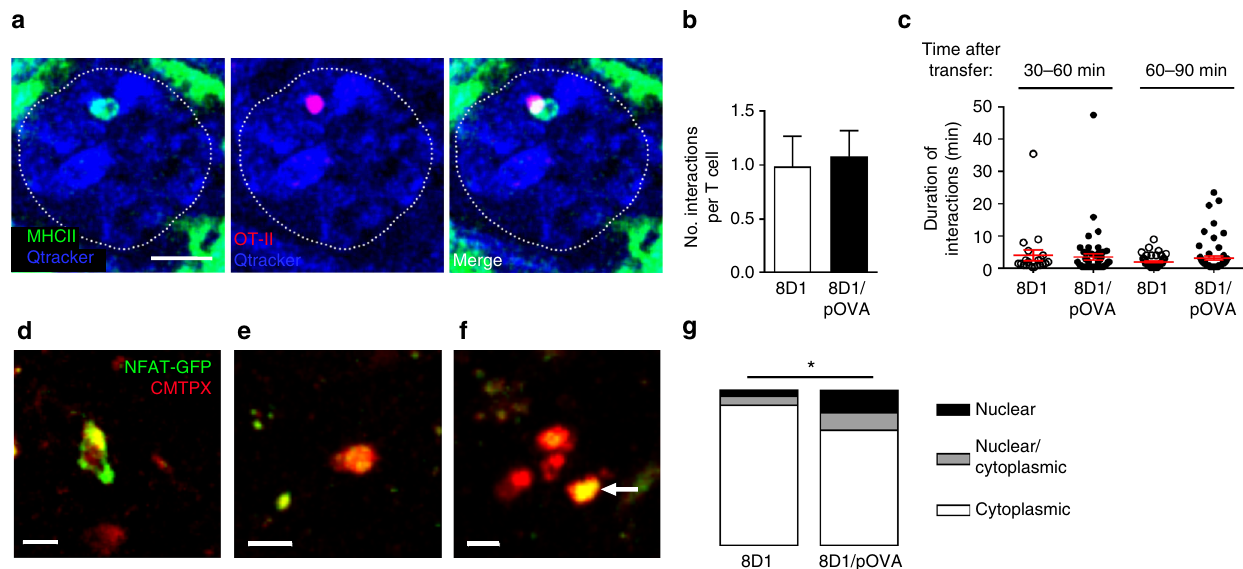
Fig. 4 CD4 + T cells interact with antigen-presenting cells in glomeruli and undergo activation. a – c OT-II cells were transferred into MHCII-EGFP mice